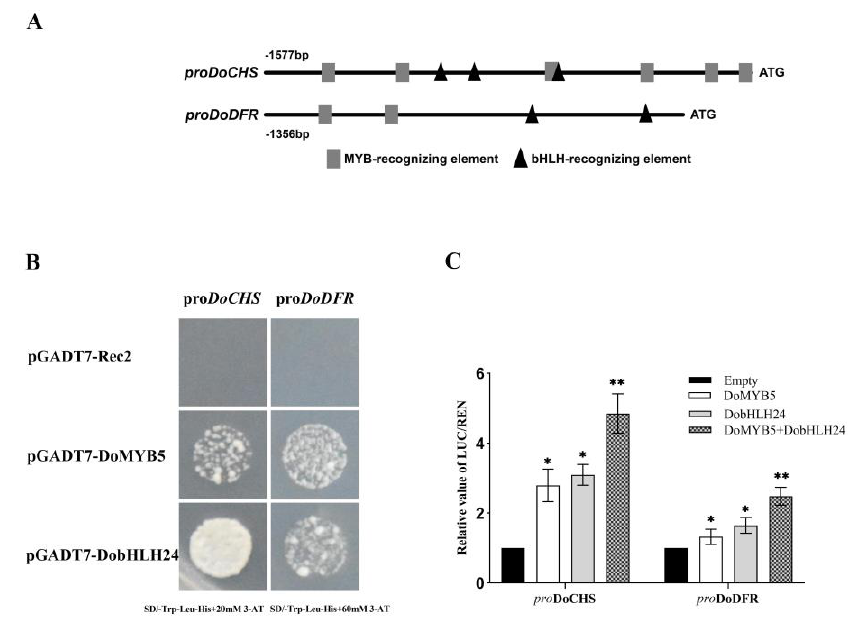
Figure 6. DoMYB5 and DobHLH24 activate the promoters of DoCHS and DoDFR . ( A ) Pattern diagram of the promoters of DoCHS and DoDFR . Triangles, bHLH-recognizing elements; rectangles, MYB-recognizing elements. ( B ) DoMYB5 and DobHLH24 bound directly to the promoters of DoCHS and DoDFR in yeast one-hybrid assays. ( C ) DoMYB5 and DobHLH24 activate the promoters of DoCHS and DoDFR in dual-luciferase assays. pro: promoter. * Significant difference ( p < 0.05). ** Extremely significant difference ( p < 0.01).